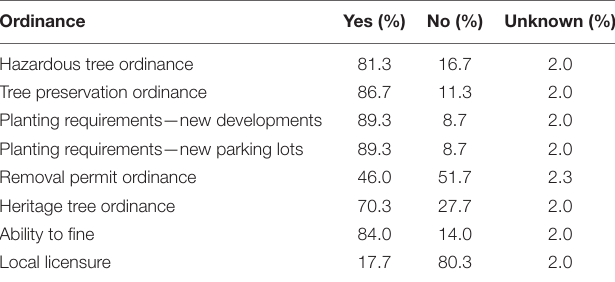
TABLE 2 | Proportion of municipalities in our study with the following tree-related